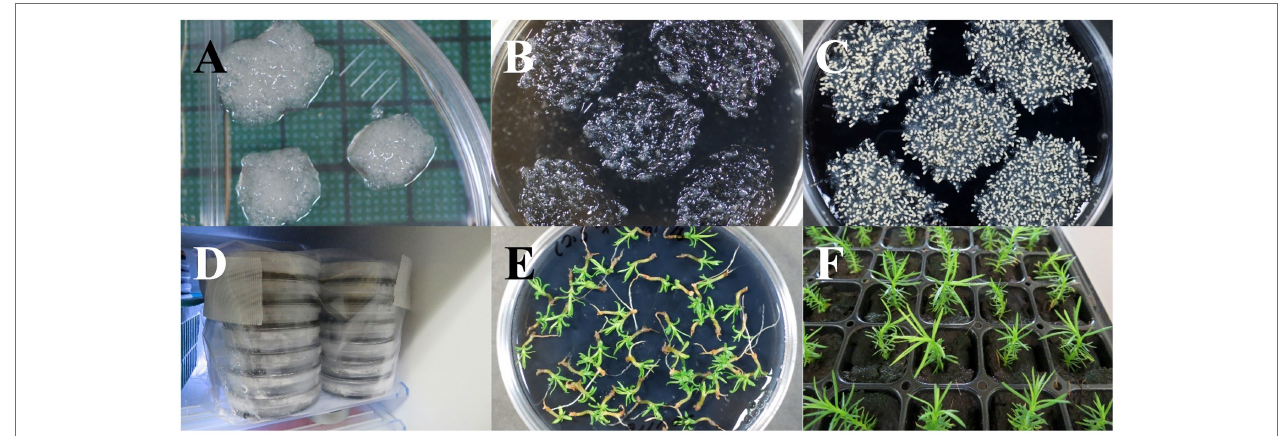
FIGURE 2 | Maturation and storage of somatic embryos of pollen-free sugi ( C. japonica ). (A) Embryogenic cell proliferation after 2 weeks of culture. (B) Proliferated embryogenic cells homogeneously dispersed into the maturation medium. (C) Somatic embryo maturation after approximately 6 weeks of culture. (D) Storage of somatic embryos at 5 ° C. (E) Germination of somatic embryos after 2 years of storage at 5 ° C. (F) Regenerated somatic plantlets from 2 year stored embryos transferred into plant plugs for ex vitro acclimatization. Diameter of plates: 90 mm; size of plant plugs: 23 × 23 × 38 mm.